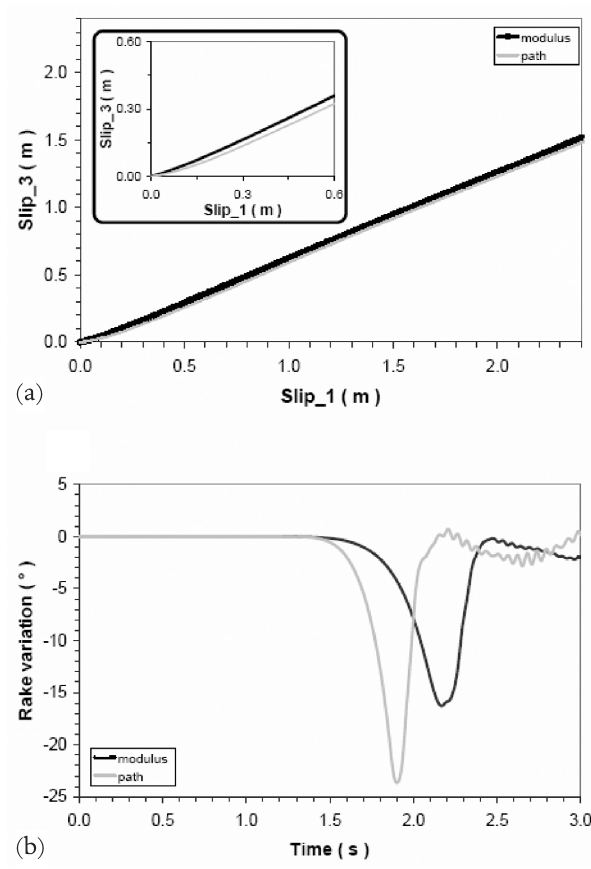
Figure 10. (a) The same as Figure 3a, but now in the case of Model C, having heterogeneous initial shear stress (see Table 1). The selected fault receiver is located at (26.25,7) km. (b) Time evolution of the rake variation (with respect to the initial value) for the two